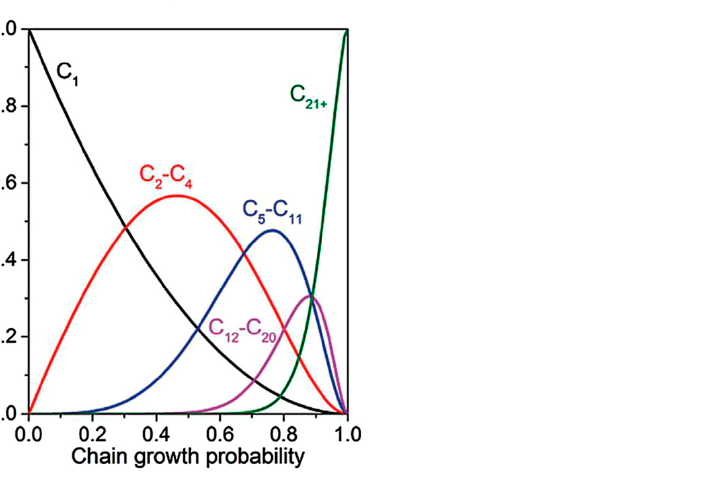
Figure 2. Product distribution as predicted by the Anderson–Schulz–Flory (ASF) model. Adapted with permission from ref. [30]. Copyright 2021 Elsevier.